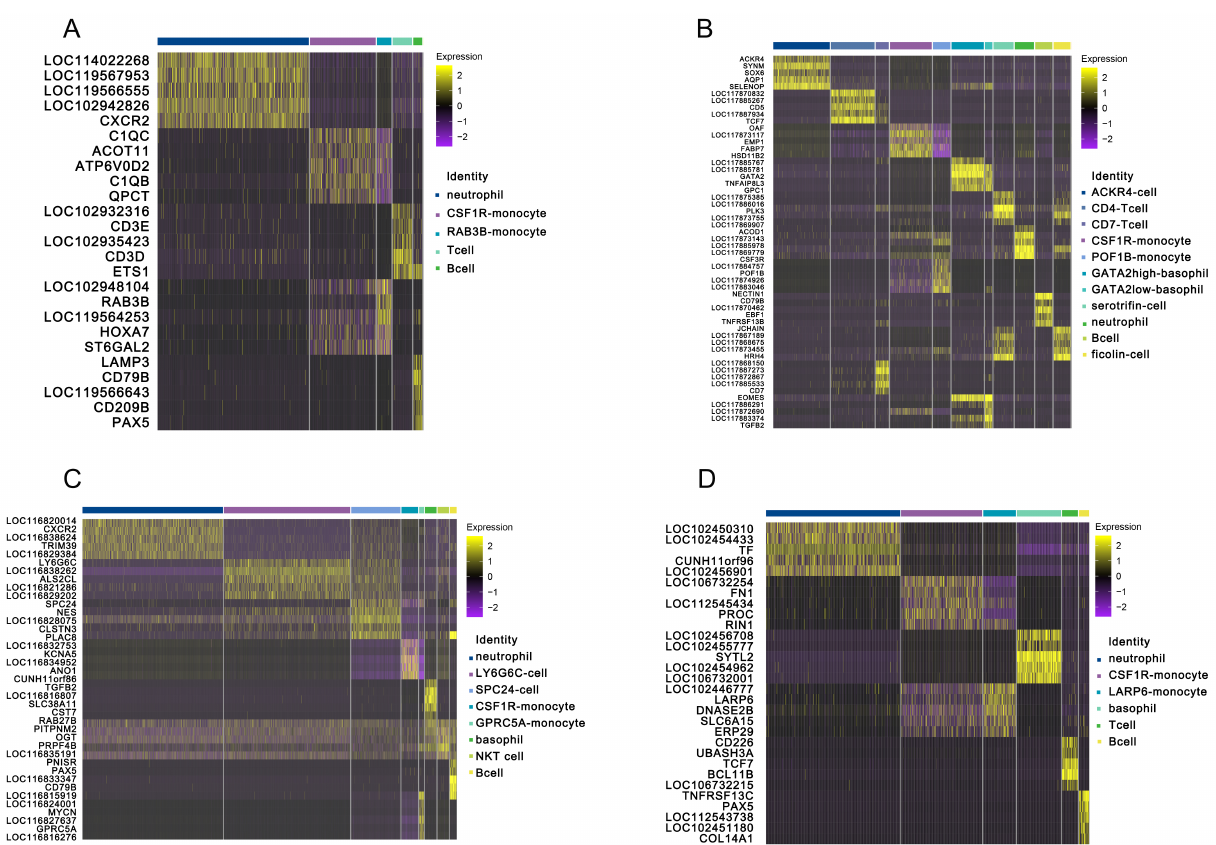
Figure 3. Heat map of upregulated genes in the peripheral blood immune cells of